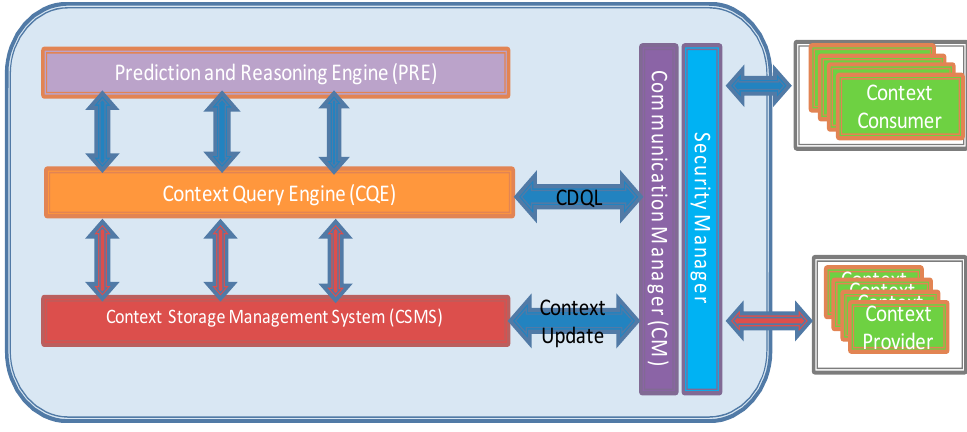
Figure 3. CoaaS reference architecture.